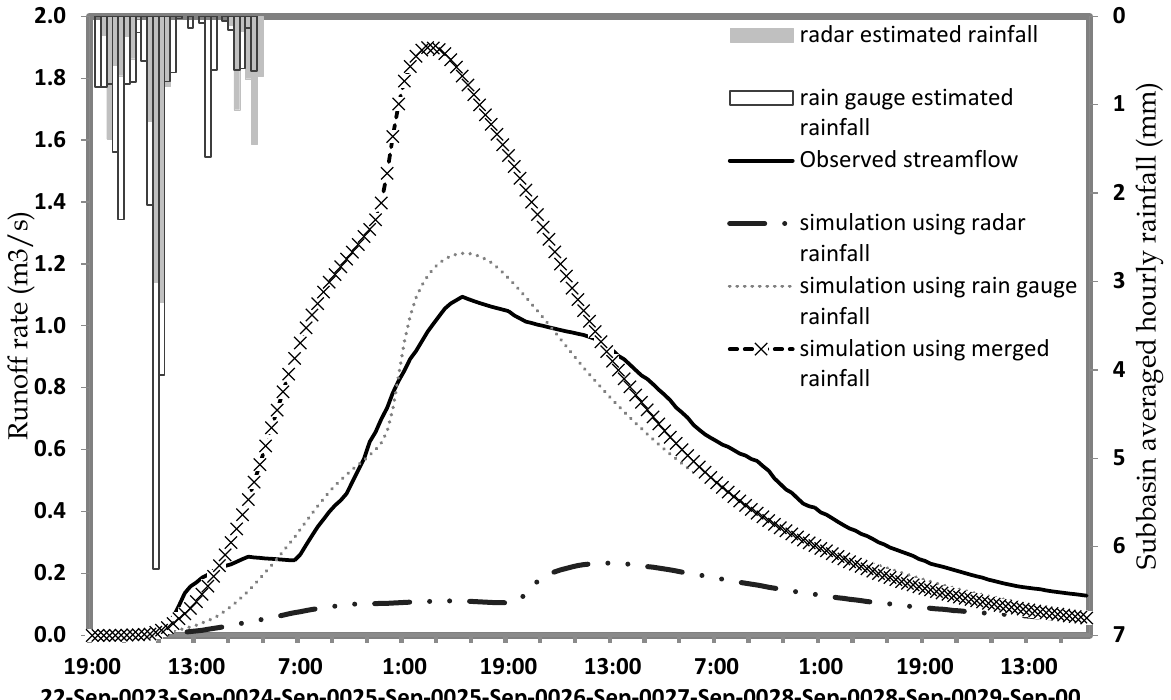
Figure 20. Comparison of estimated and observed hydrographs using different rainfall estimates for the 9 July 2000 event with Green and Ampt modeling option.